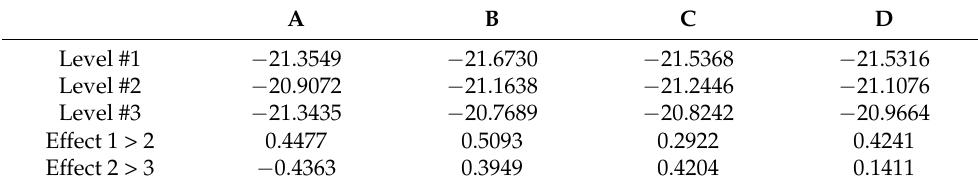
Table 9. Convex factors/level